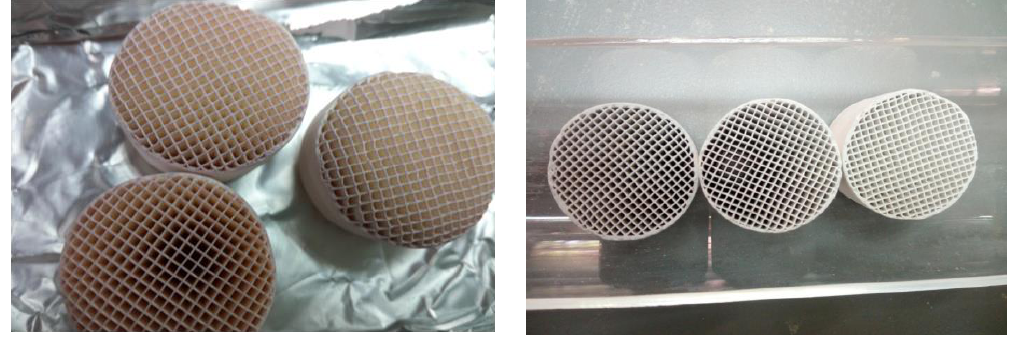
Figure 1. Monolith structure.